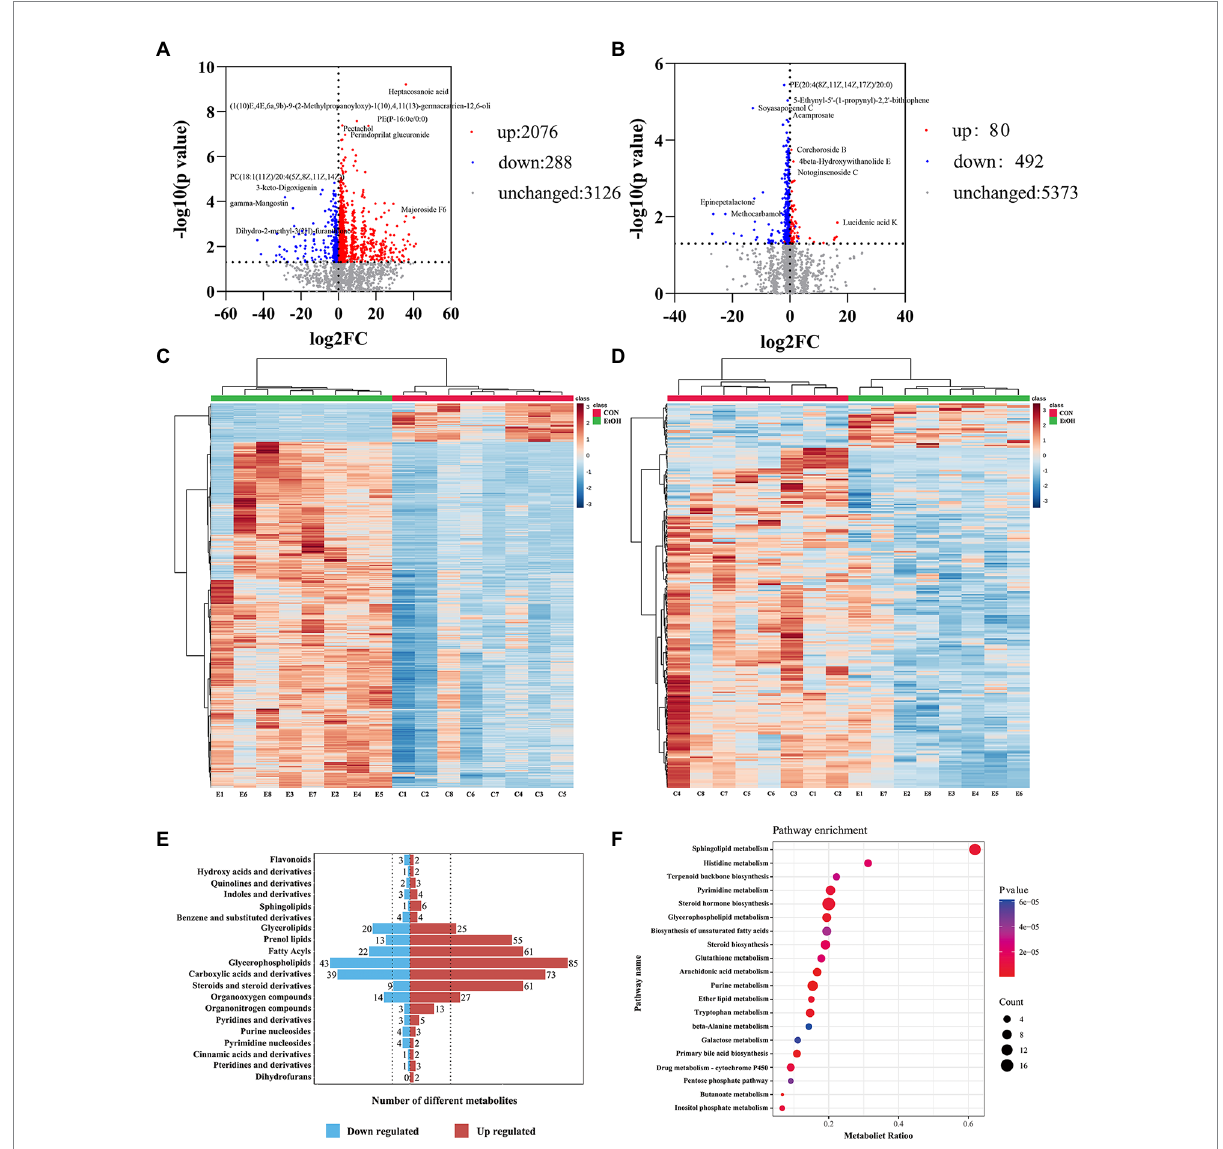
FIGURE 8 The fecal metabolic profile changed in AUD rats. Differential metabolites in fecal identification between EtOH and CON group at positive (A,C) and negative (B,D) ion mode. Expression of differential metabolites in the two groups was represented by Volcano plot (A,B) and heat maps (C,D) . The number of differential metabolites were annotated and classified based on the HMDB database (E) . The enrichment pathway of fecal differential metabolites by Kyoto encyclopedia of genes and genomes (KEGG) analysis (F)